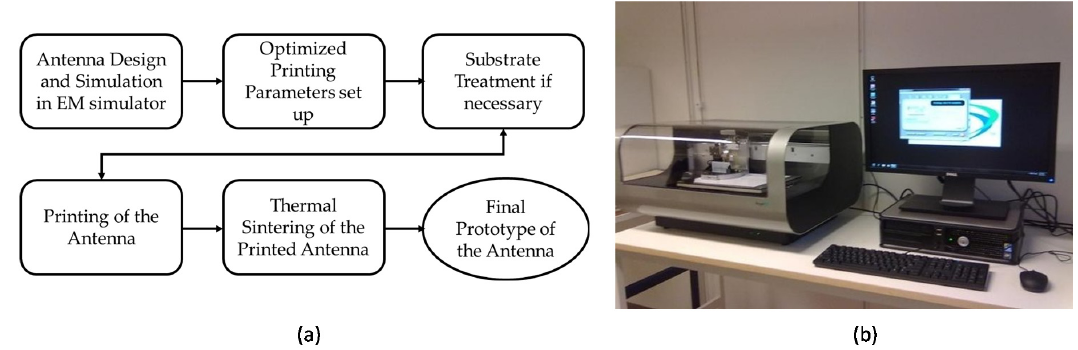
Figure 5. Overview of the inkjet printing process for antenna fabrication. ( a ) Flowchart of the inkjet printing process [91] and ( b ) Dimatix Materials Printer, DMP-2800 (FUJIFILM Dimatix Inc., Santa Clara, CA, USA), and the PC that is used to control the printer.